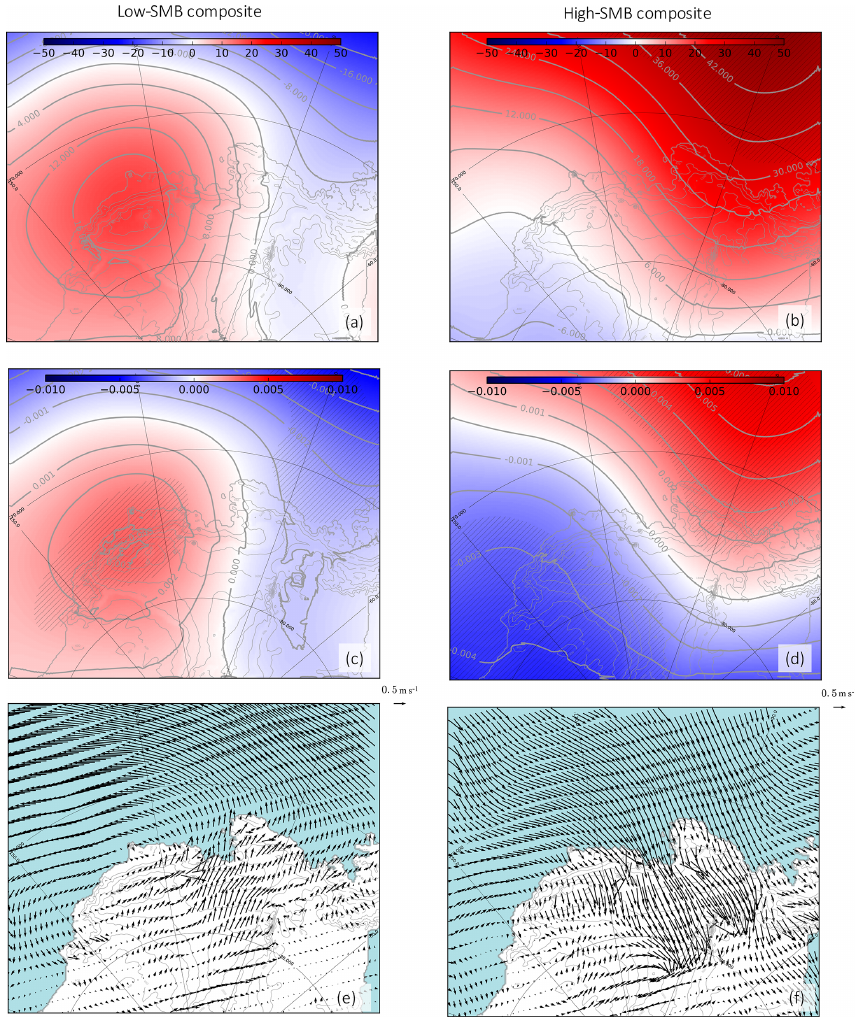
Figure 9. (a, b) The 500hPa geopotential height (m), (c, d) 500hPa geopotential height divided by the domain-averaged value for each season and (e, f) 10m wind (ms − 1 ) anomalies during low-SMB summers (left) and high-SMB summers (right); scales of arrow lengths are shown near the upper right corner of panels (e) and (f) . Anomalies are calculated as high or low composites minus the climatology over 1979–2017. The hatched area (a–d) represents significance > 90% calculated with Welch’s t test. Table 3. Correlation R between ENSO, SAM, and ASL indices and the SMB over individual drainage basins in austral summer. The statistical significance (Welch’s t test) is written within brackets. The last column shows the correlation of a multi-linear regression to the four indices using a least absolute shrinkage and selection operator (LASSO; Tibshirani,